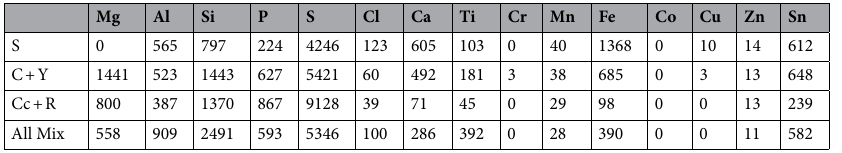
Table 10. Average composition of elements in sugarcane bagasse, cassava peels + yam peels mixed biomass, corn cobs + rice husks mixed biomass and the mixture of all five biomass samples. S = sugarcane bagasse. C + Y = Cassava plus yam peels. Cc + R = Corn cobs plus rice